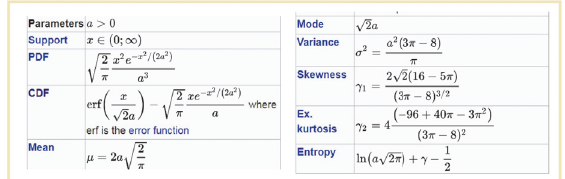
Figure 11: Maxwell–Boltzmann